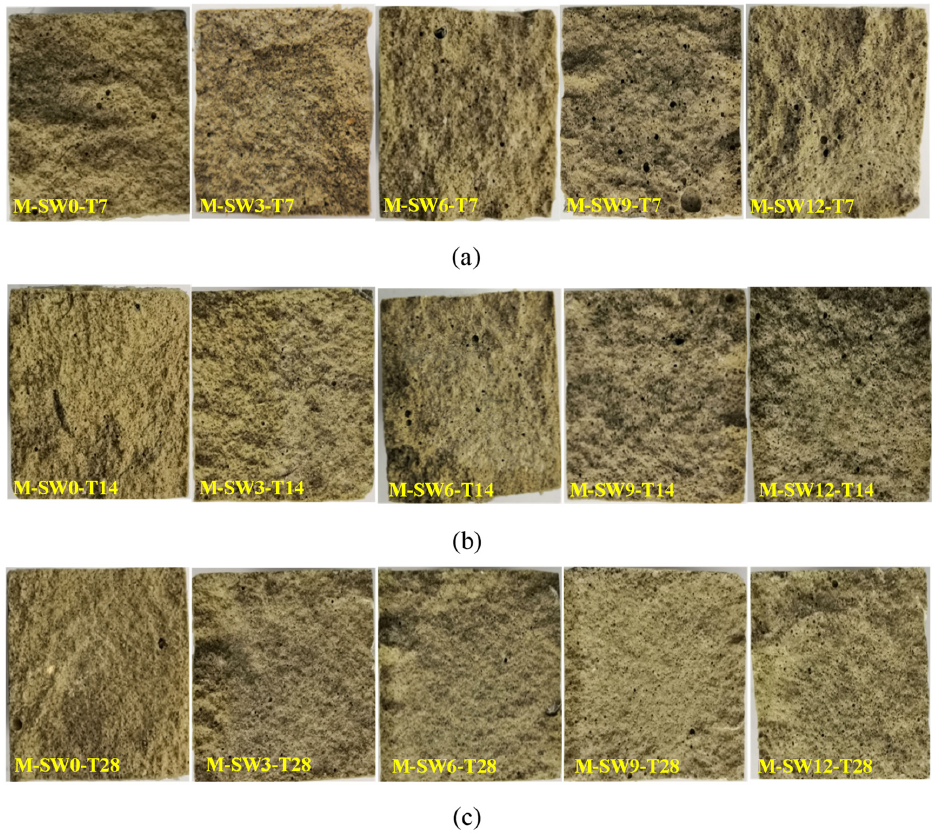
Figure 6. Section of failed specimens. ( a ) T7; ( b ) T14; ( c ) T28.